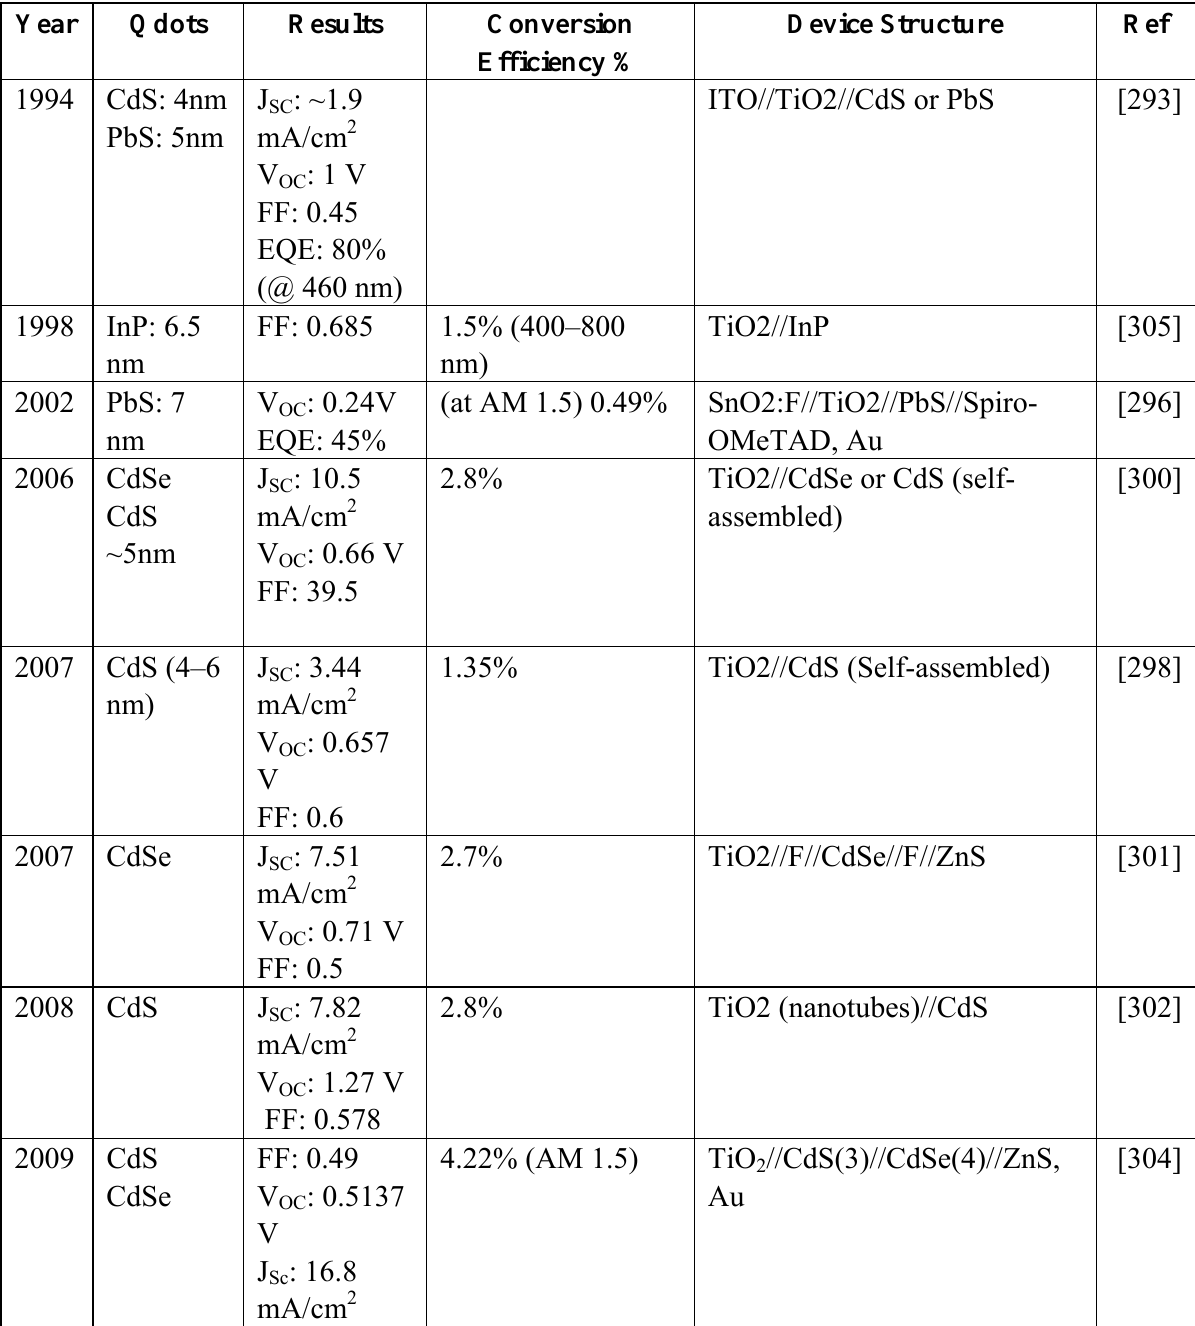
Table 9. Selected data for Qdot sensitized